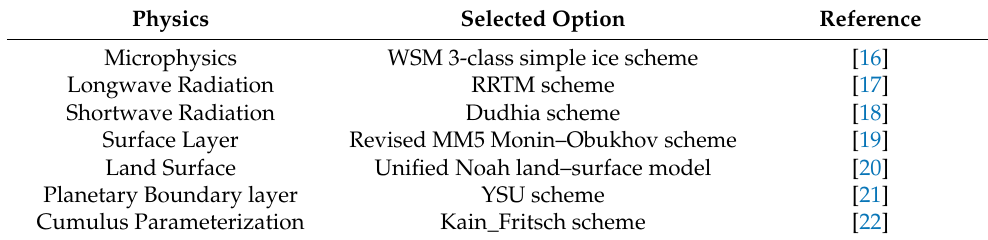
Table 1. Summary of WRF configuration.